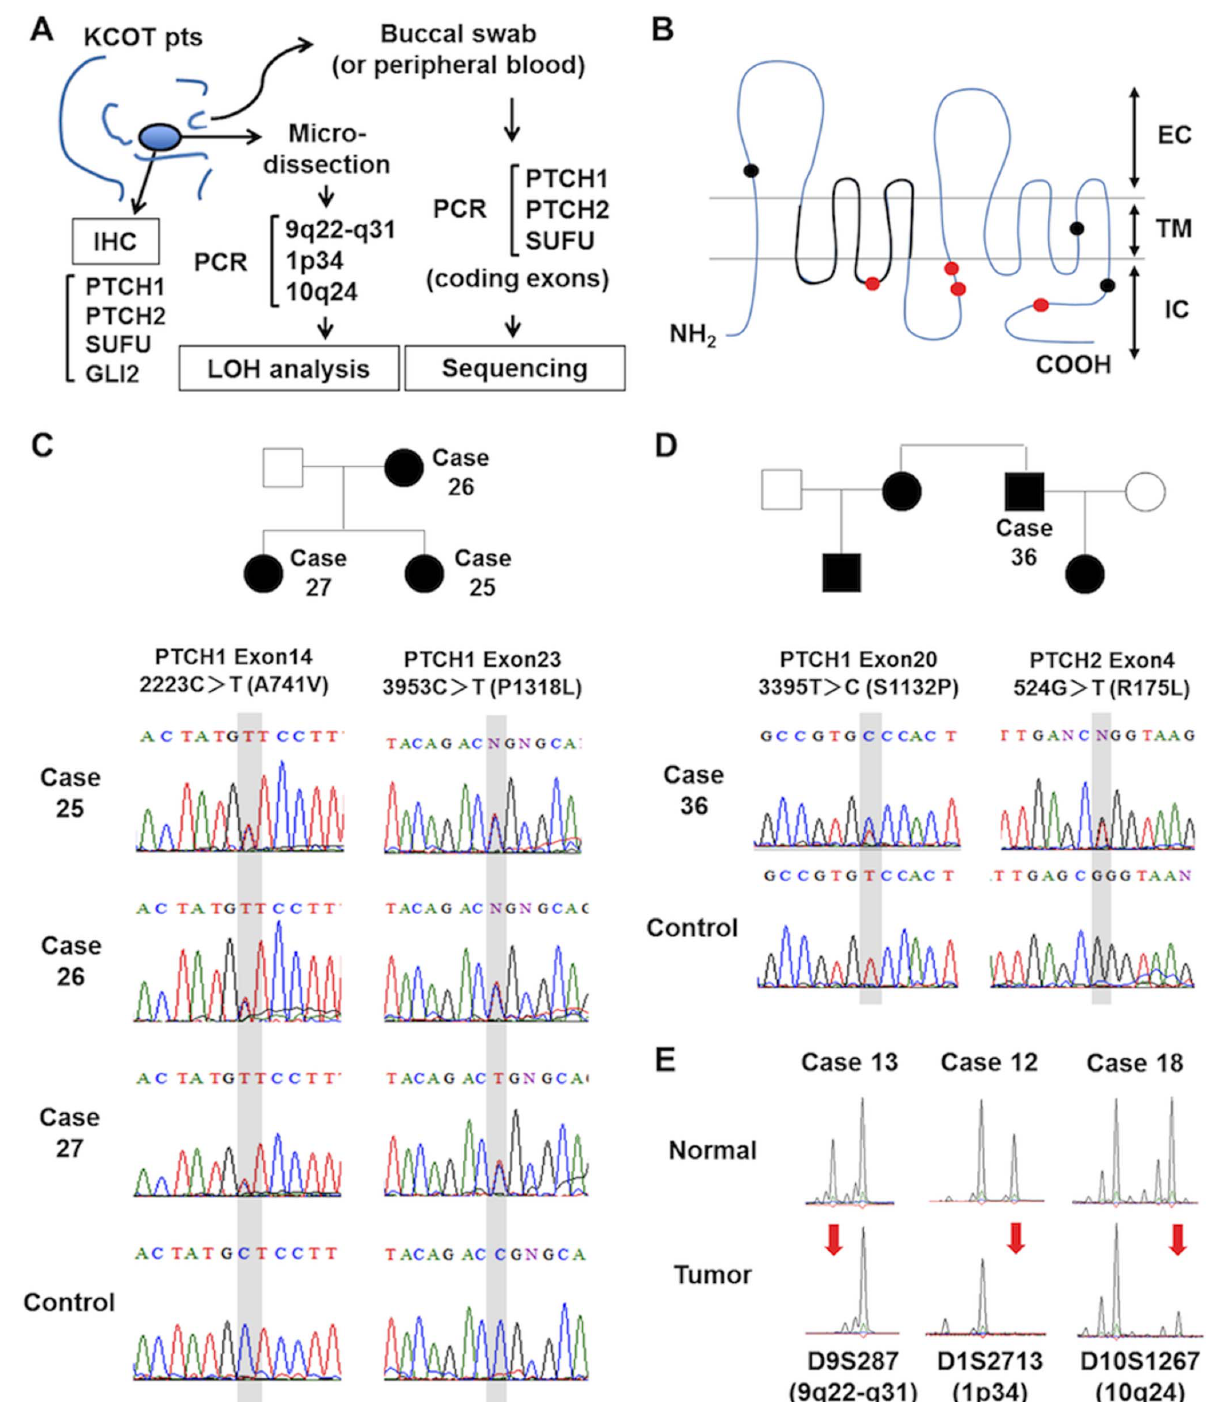
Figure 1. Analyses of gene mutation and LOH. A) Experimental scheme. Mutational analysis was conducted on patients with KCOT. LOH analysis and immunohistochemical analysis were performed using surgically excised KCOT specimens. B) Predicted secondary structure of PTCH1, showing the location of mutations. The black circles designate previously-reported mutations, and the red circles designate novel mutations. EC, Extracellular; IC, Intracellular; TM, Transmembrane domain. The thick black line represents a sterol-sensing domain. C) A family tree of Case 25, 26, 27 and the electropherograms showing the PTCH1 mutations. Two missense mutations (2223C . T, 3953C . T) were found in the PTCH1 coding region in this pedigree. D) A family tree of Case 36 and the electropherogram showing missense mutations of PTCH1 (3395T . C) and PTCH2 (524G . T). E) Electropherograms showing LOH of PTCH1 (D9S287, Case 12), PTCH2 (D1S2713, Case 13) and SUFU (D10S1267, Case 18) (arrows). Normal, normal cells; Tumor, KCOT cells.